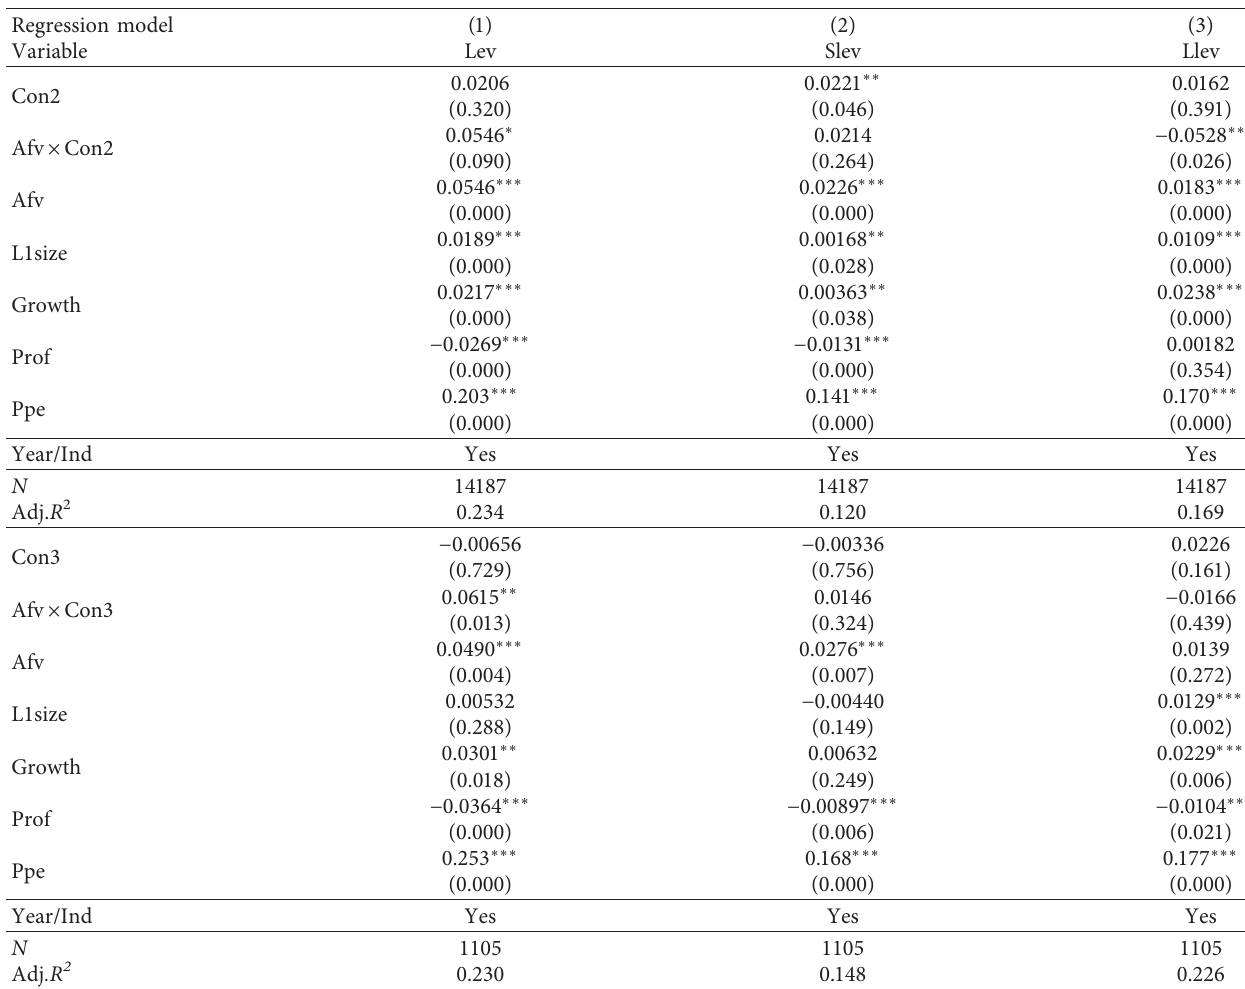
Table 10: Tests on earnings forecasts and executive characteristics measuring overconfidence.